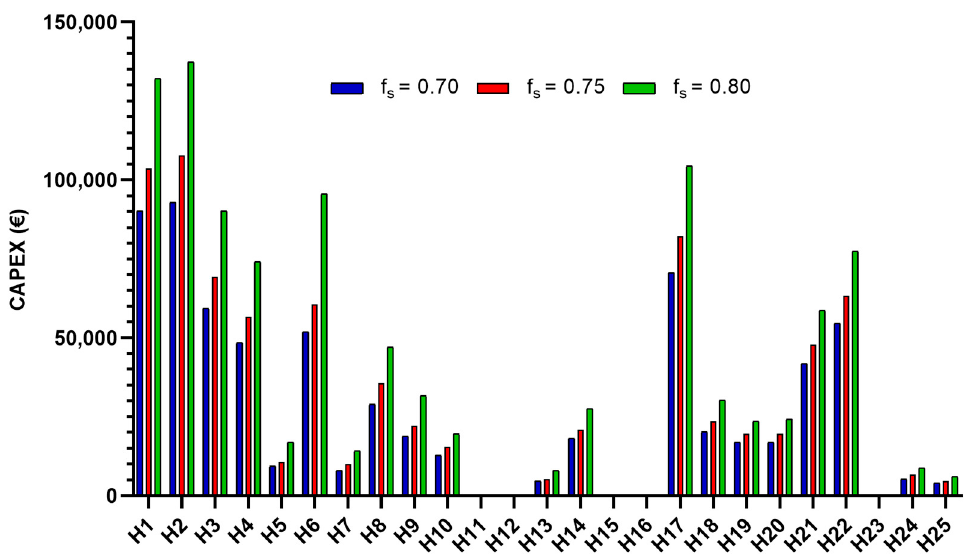
Figure 2. Capital expenditure according to the solar factor for each hospital.